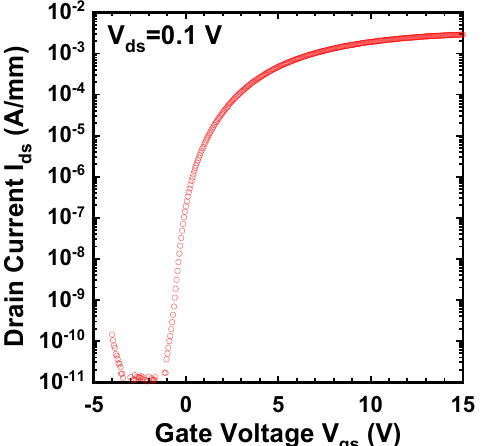
Figure 10. I ds - V gs and g m - V gs characteristics at a linear region of the DMOSFET.